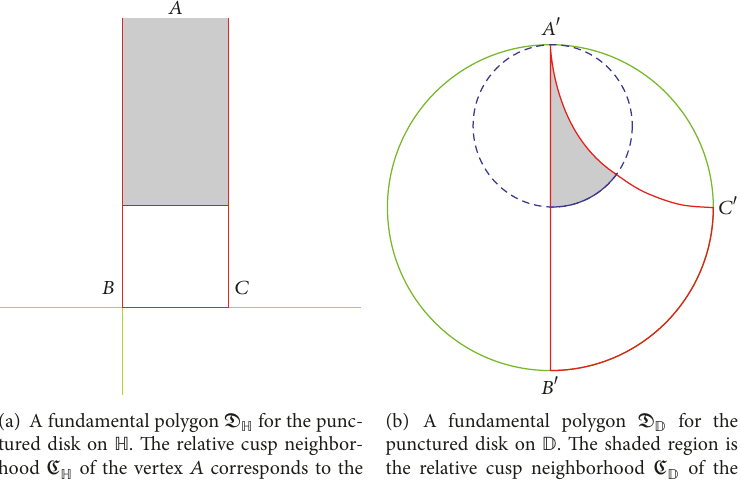
Figure 4: Fundamental polygons for the uniformization of D ∗ to the Poincar´e half plane and to the hyperbolic disk.